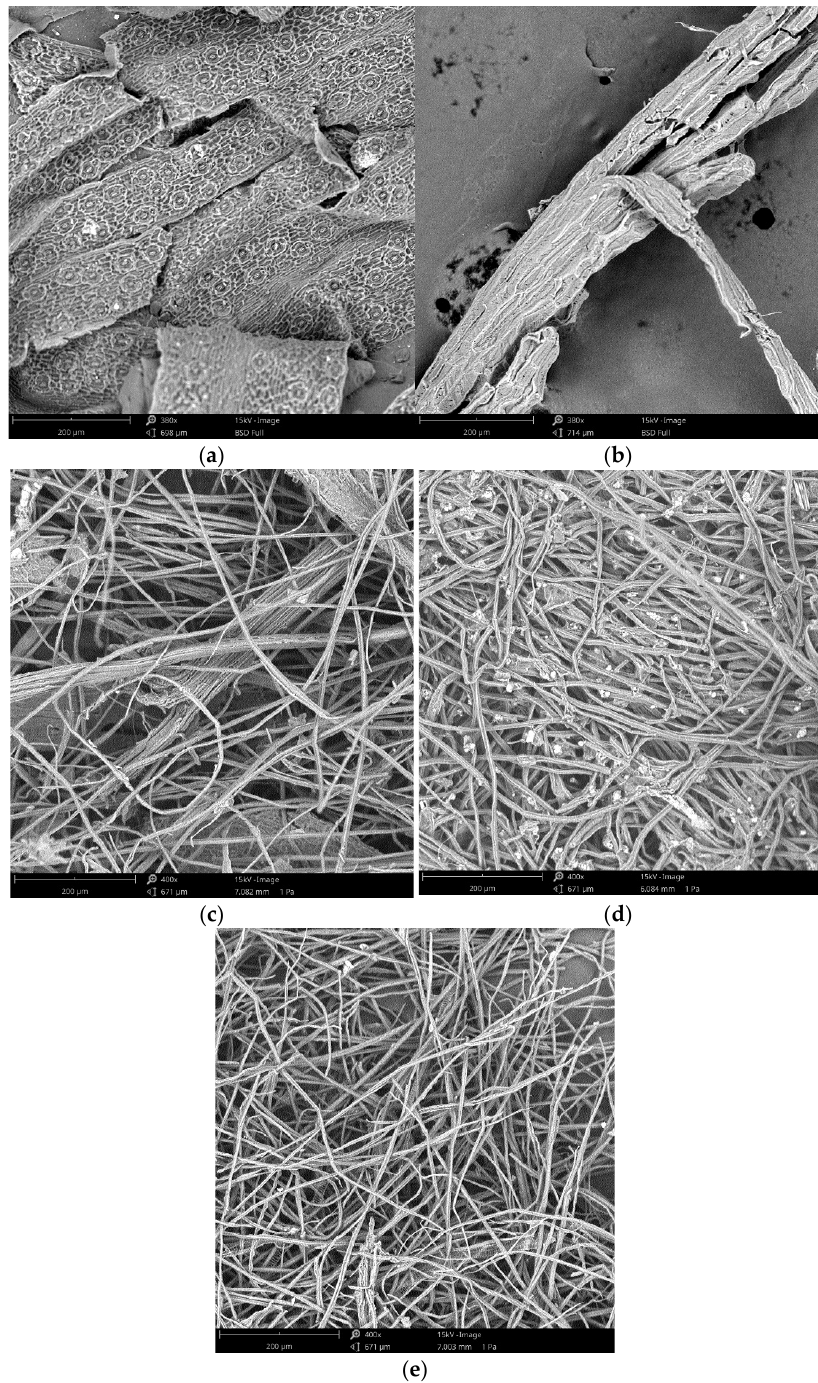
Figure 6. SEM images of fibers extracted at different steam-explosion times. ( a ) Untreated palm leave, ( b ) Leaves before 15 min of steam-explosion, ( c )15 min, ( d ) 25 min, ( e ) 33 min. The SEM images corresponding to 15 min, 25 min and 33 min show the efficiency of the multistep process to eliminate lignin and hemicellulose from biomass. All photo- graphs prove the presence of cellulosic fibers, which indicates their successful extraction.